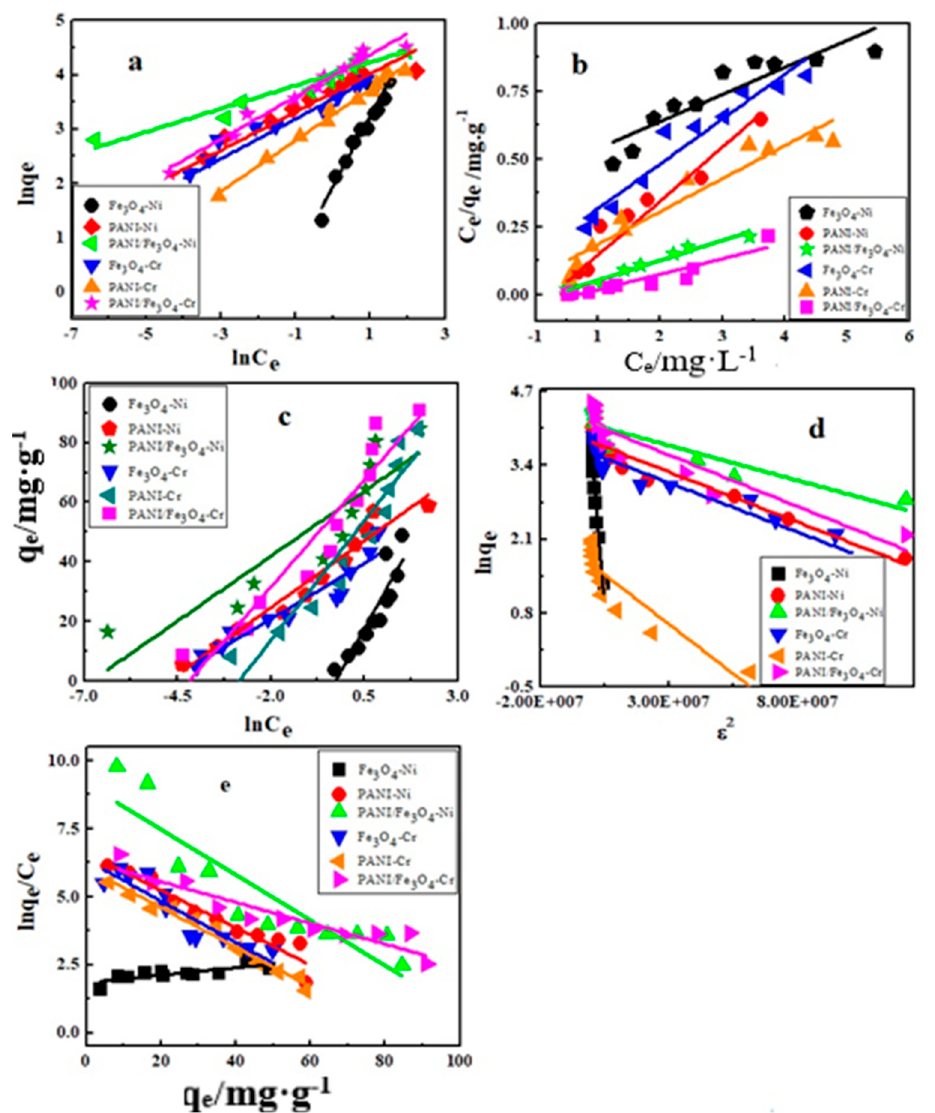
Figure 5. Adsorption isotherms ( a ) Freundlich, ( b ) Langmuir, ( c ) Tempkin, ( d ) Dubinin–Radushkevich (D–R), and ( e ) Elovich models of Cr(VI) and Ni(II) adsorbed on Fe 3 O 4 , PANI, and PANI/ Fe 3 O 4 composites.